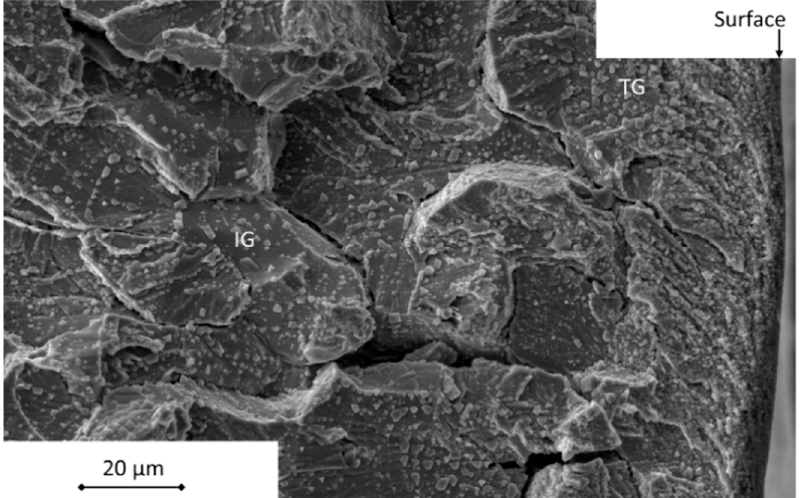
Figure 3. Fracture surface of 08Ch18N10T AS steel after accelerated EAC testing (strain rate of 1 × 10 − 7 s − 1 at the tension loading up to rupture) in HT water (320 °C, KOH, <20 ppb O 2 , without H 2 gas addition) showing the path of the crack from its initiation in the surface layer (deformed by harsh turning), where it had TG and cleavage-like character, to its propagation into depth, where the path was locally IG.